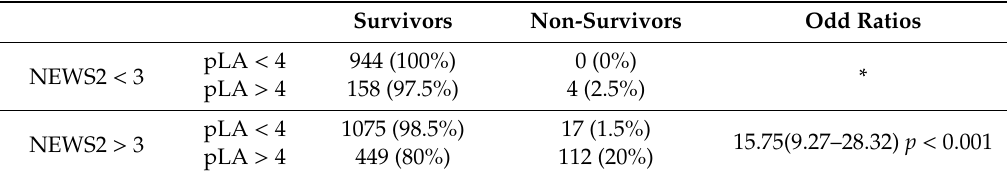
Table 6. Mortality of groups resulted from the combination of NEWS2 above and below 3 and prehospital lactate above and below the cuto ff (4 mmol /